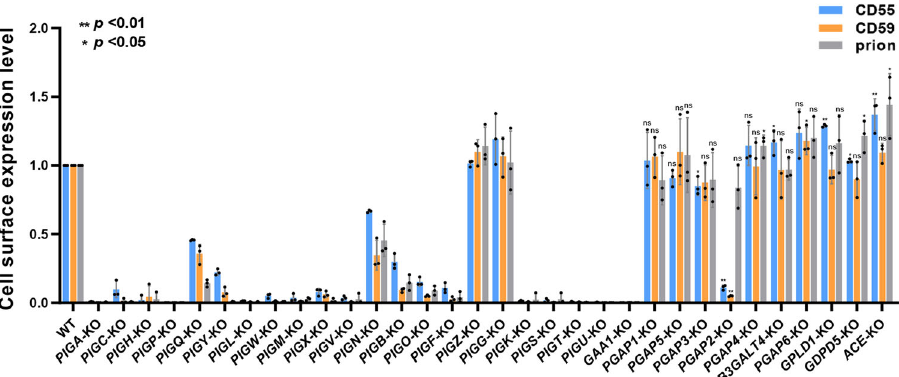
Fig. 2 GPI-AP expression on the cell surface in the GPI-knockout cell library. Cell surface expression of three endogenous GPI-APs, CD55, CD59, and prion, was detected by fl ow cytometry. The expression level of GPI-APs in WT cells was set as 1, and the relative mean ± SD values from three independent experiments were displayed in a bar plot. CD55, blue; CD59, orange; prion, gray. * p < 0.05; ** p < 0.01 according to an unpaired Student ’ s t test. ns not signi fi